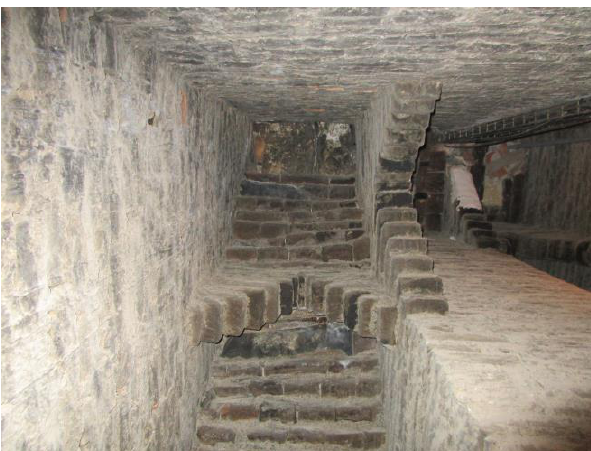
Figure 11. Corbel arches for bracing the walls and corbel vault for supporting the steps and the landing.